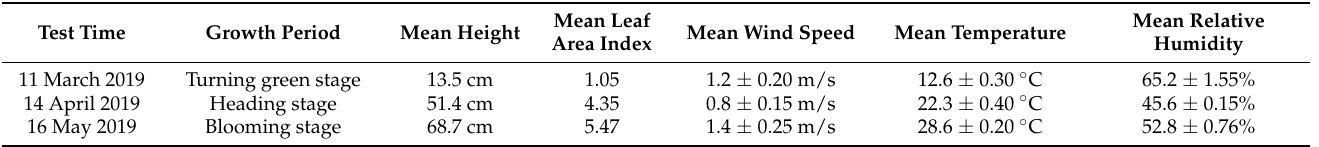
Table 1. The wheat characteristics and weather conditions.